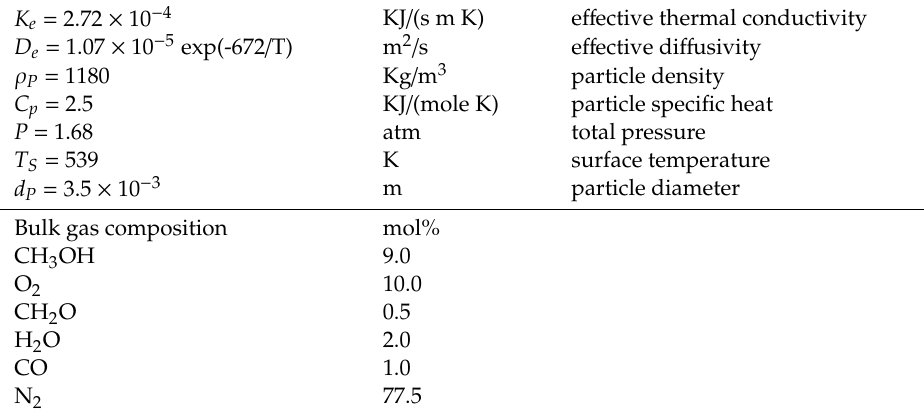
Table 1. Physico-chemical data for the calculation.